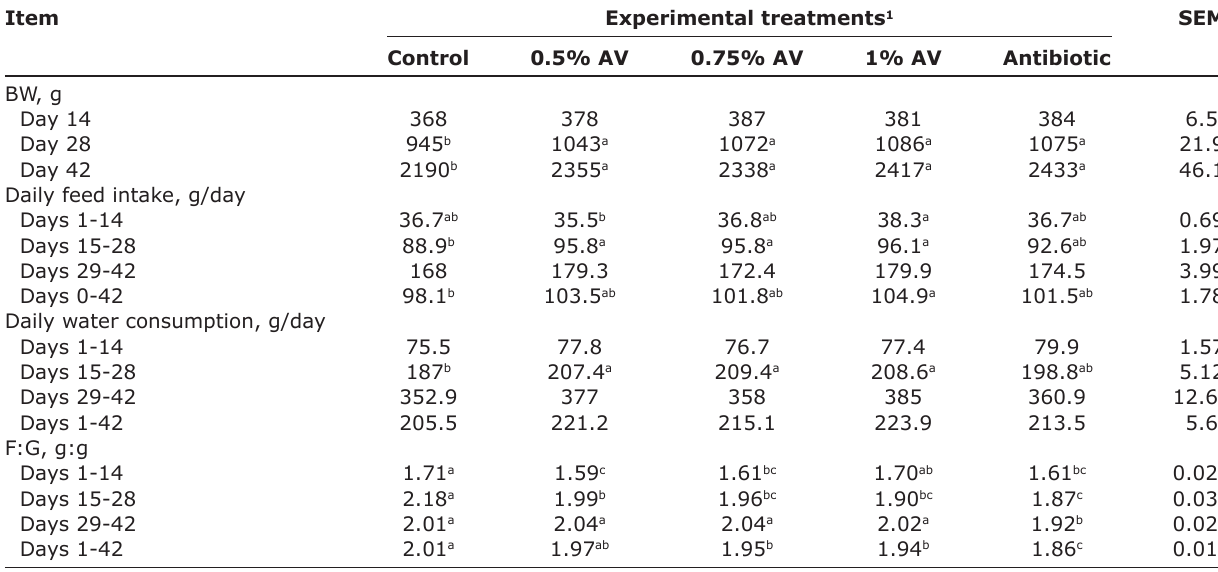
Table-3: Effect of antibiotic supplementation in the diet and AV supplementation via drinking water on performance indices of broiler chicks. Item